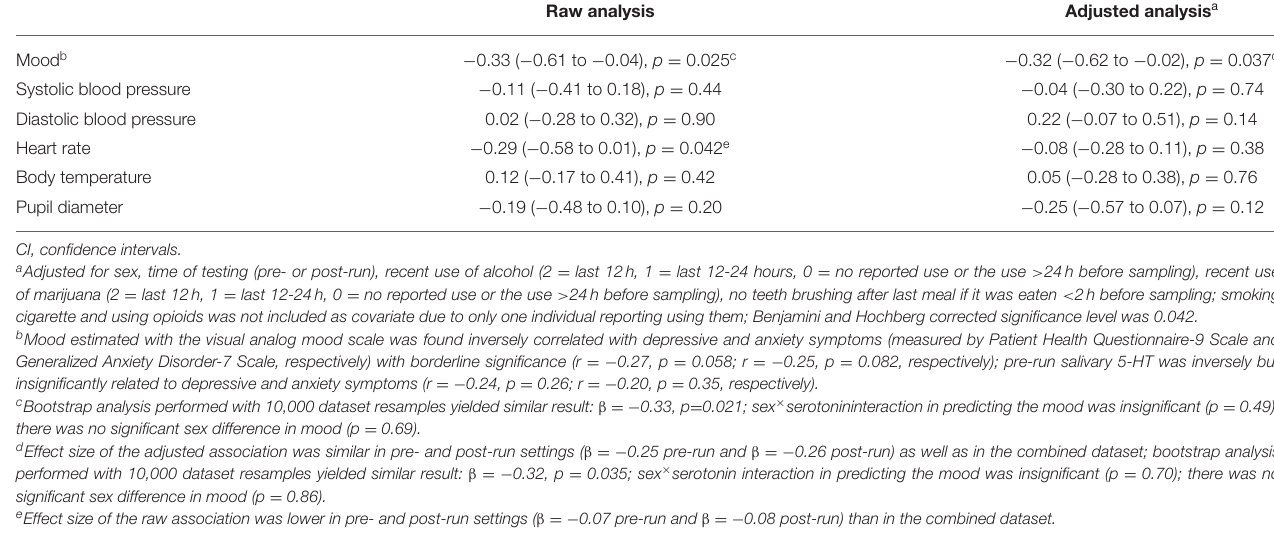
TABLE 2 | Association between concentration of serotonin in saliva and output characteristics.